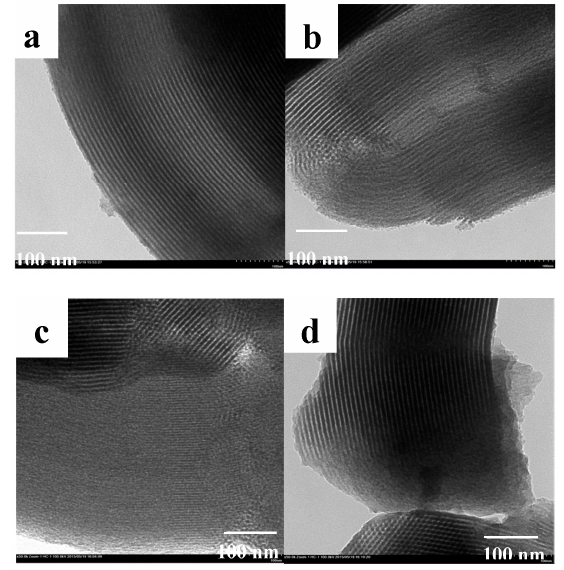
Figure 5. TEM images of ( a ) pure-silica SBA-15; ( b ) SBA-APTES; ( c ) SBA-Br; and ( d )